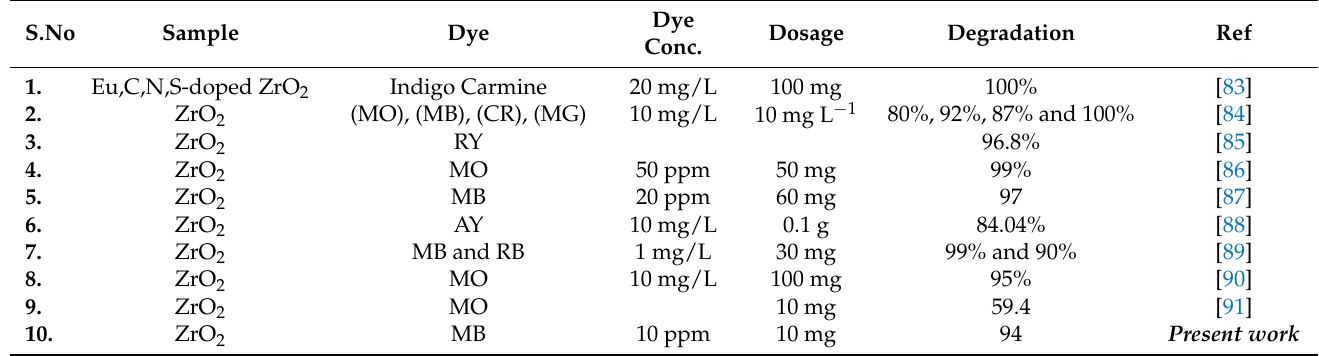
Table 1. Photocatalytic dye degradation comparison table of ZrO 2 NPs.